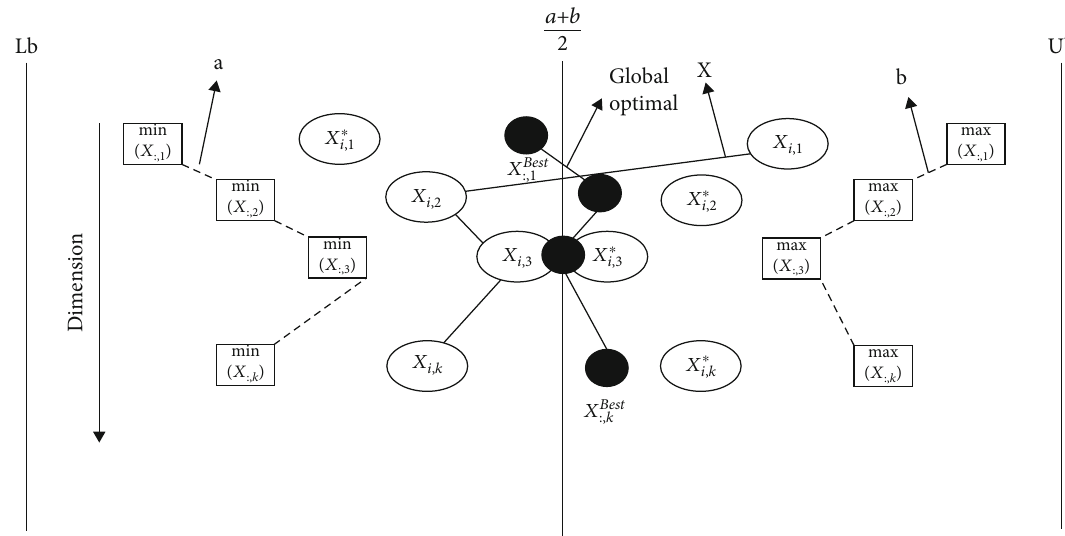
Figure 4: Dynamic per dimension reverse